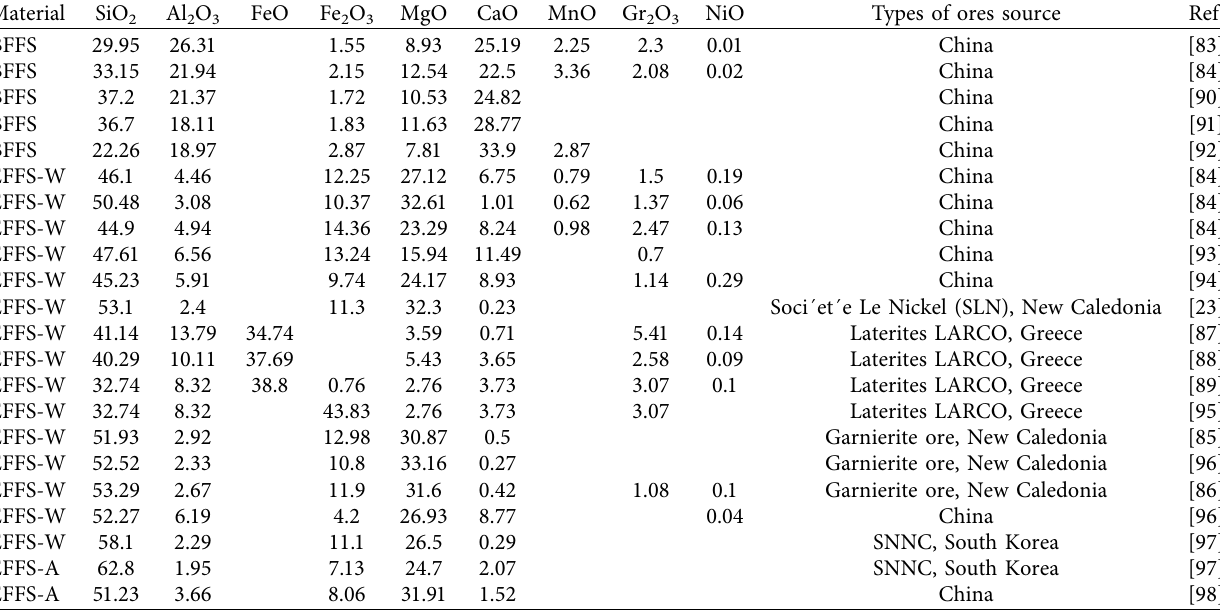
Table 2: Chemical composition of ferronickel slag.